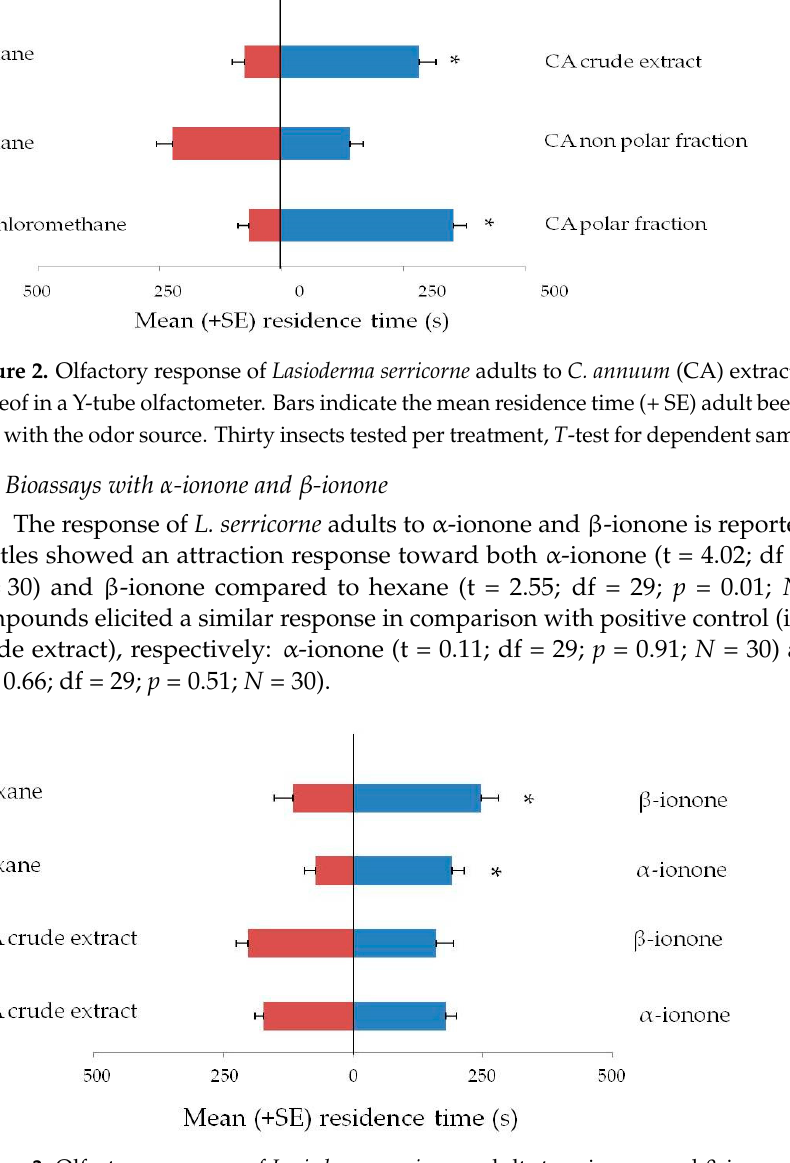
Figure 3. Olfactory response of Lasioderma serricorne adults to α -ionone and β -ionone versus solvent or C. annuum extract in Y-tube olfactometer. Bars indicate the mean residence time (+SE) adult beetles spent in the arm with the odor source. Thirty insects tested per treatment, t-test for dependent samples, * p ≤ 0.01.